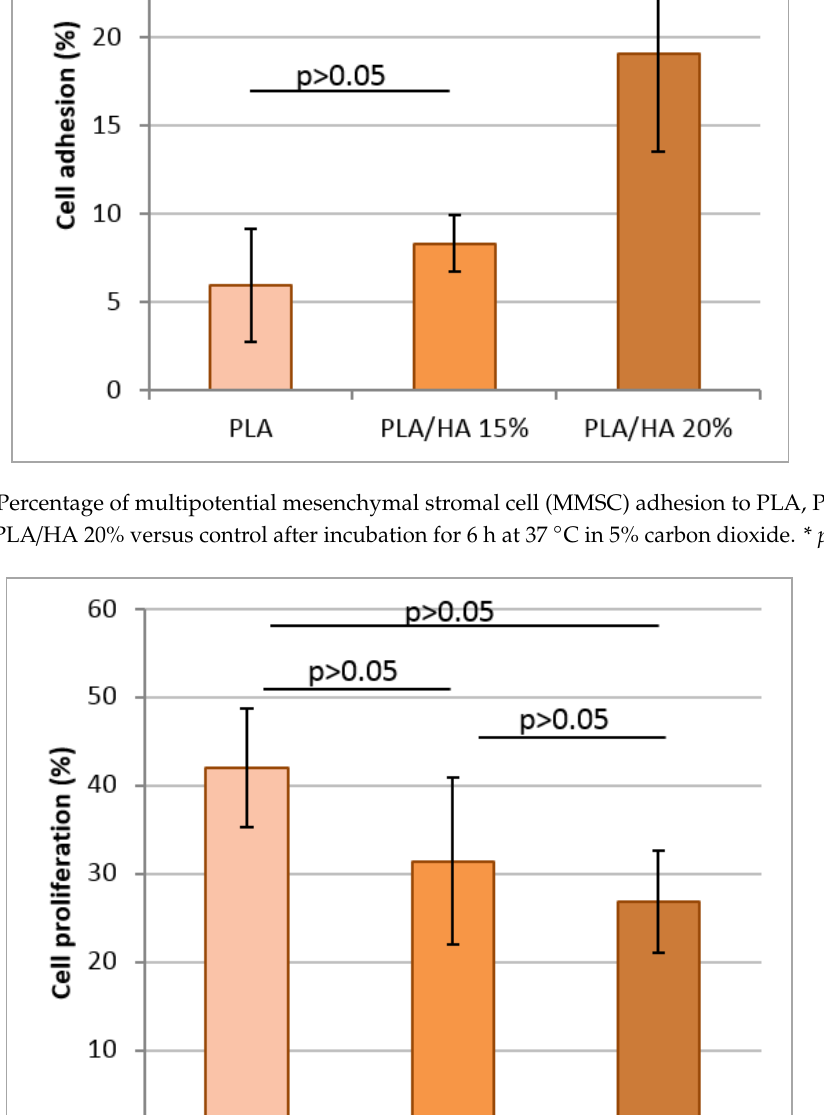
Figure 5. Percentage of multipotential mesenchymal stromal cell (MMSC) adhesion to PLA, PLA/HA 15%, and PLA/HA 20% versus control after incubation for 6 h at 37 °C in 5% carbon dioxide. * p < 0.05.